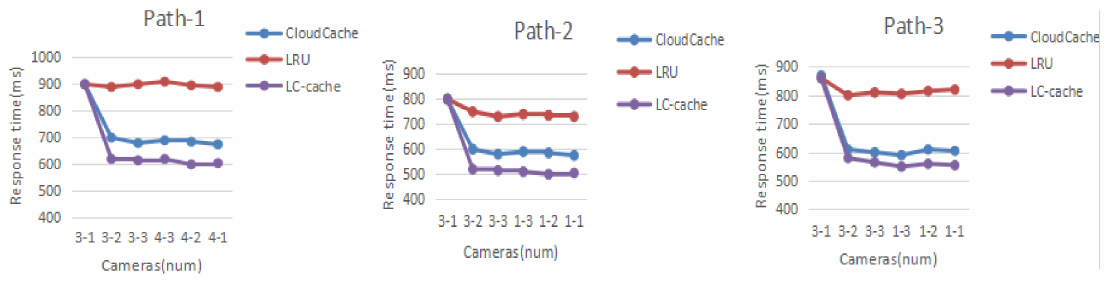
Figure 6. The First Playback Response